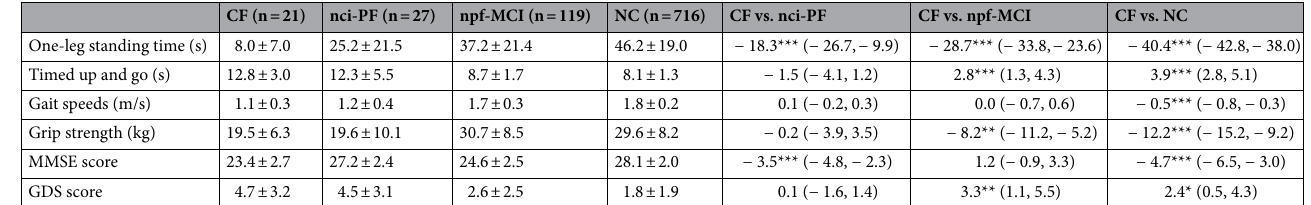
CF vs. npf-MCI CF vs.